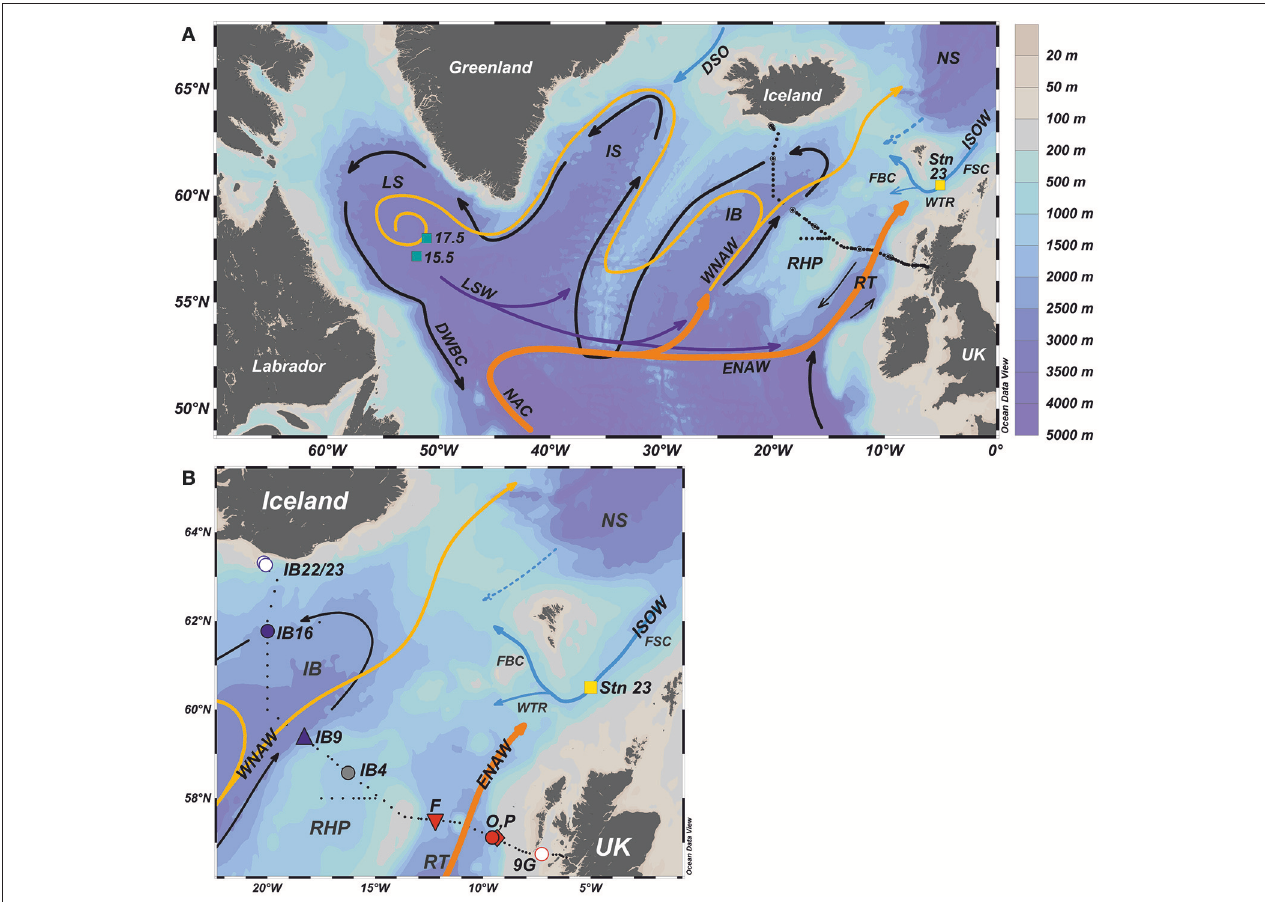
FIGURE 1 | (A) Location map with the 2015 Extended Ellett Line (EEL) stations in black dots. Deep, ocean currents are indicated by black arrows (below the pycnocline). The cold overflow currents are shown by blue arrows. Dotted lines represent intermittent currents. Orange and yellow lines reflect the warm surface waters. The locations of the Faroe-Shetland Channel (FSC), Faroe Bank Channel (FBC) and Wyville Thomson Ridge (WTR) are shown. For reference in the discussion, also shown are the locations of Station 23 in the FSC (yellow square; Lacan and Jeandel, 2004b) and Stations 15.5 and 17.5 in the Labrador Sea (green squares; Filippova et al., 2017). (B) Detailed view of the 2015 EEL stations, with those sampled in this study highlighted by large labelled symbols (blue, red, grey). Water masses: DWBC, Deep Western Boundary Current; LSW, Labrador Sea Water; ISOW, Iceland-Scotland Overflow Water; DSO, Denmark Strait Overflow; NA, North Atlantic Current; WNAW, Western North Atlantic Water; ENAW, Eastern North Atlantic Water. Ocean basins: LS, Labrador Sea; IB, Iceland Basin; IS, Irminger Sea; RHP, Rockall-Hatton Plateau; RT, Rockall Trough; NS, Norwegian Sea. The figure was created using ODV software, available at https://odv.awi.de/ ( Schlitzer,